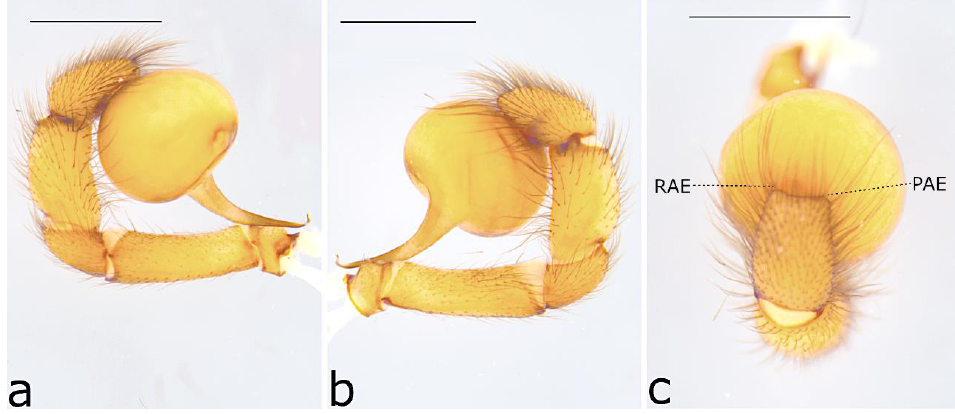
Figure 66. Ariadna ungua sp. nov. ♂ holotype (SAMA NN30481) from Lake Dam, near Lake Frome/Munda (SA): ( a ) left pedipalp, prolateral view; ( b ) same, retrolateral view; ( c ) same, cymbium. Scale bar = 1 mm.